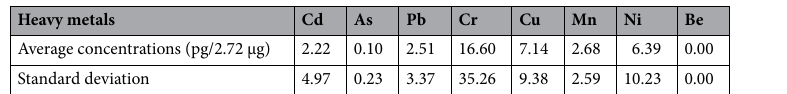
Table 1. Compositions of heavy metals in particulate matters (0.1–0.056 µm).